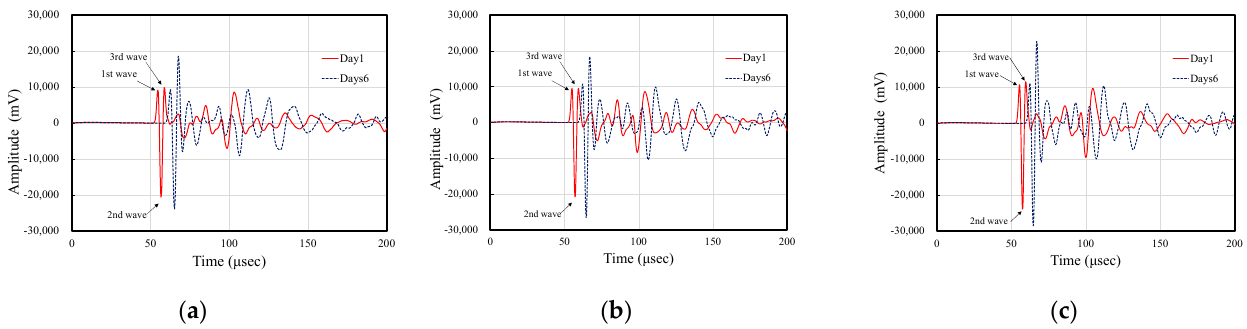
Figure 5. Comparison of the measured waveform on date 1 and 6: ( a ) 5%, ( b ) 10%, and ( c ) 14.5% air void ratio.